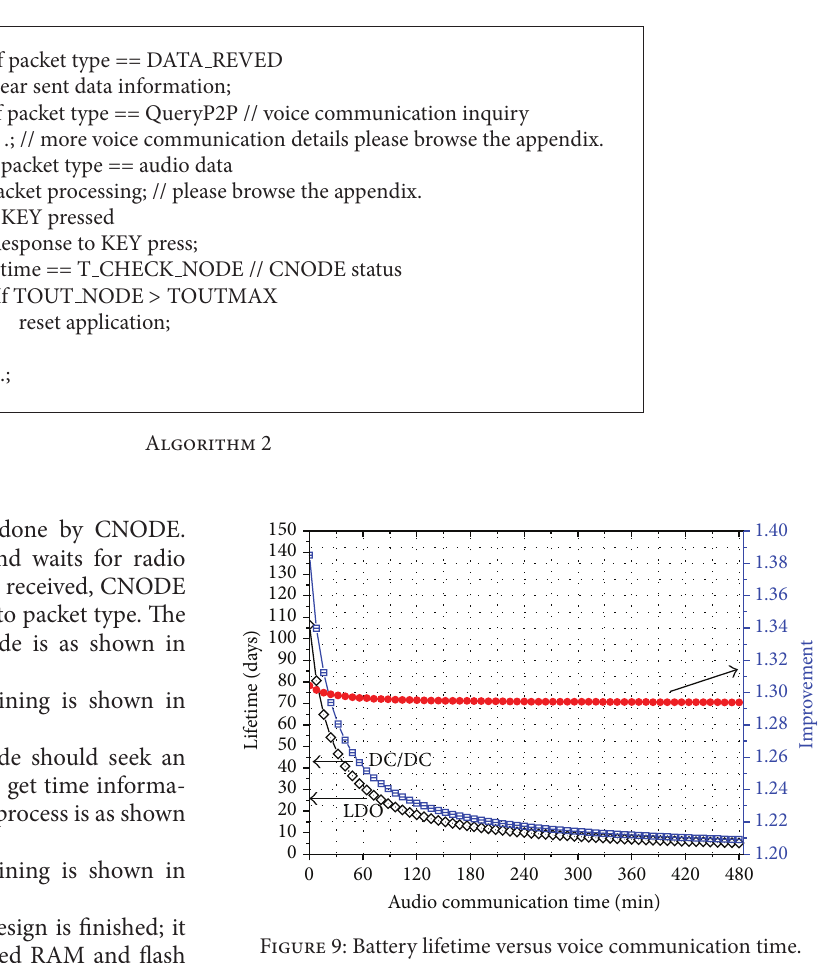
Figure 9: Battery lifetime versus voice communication